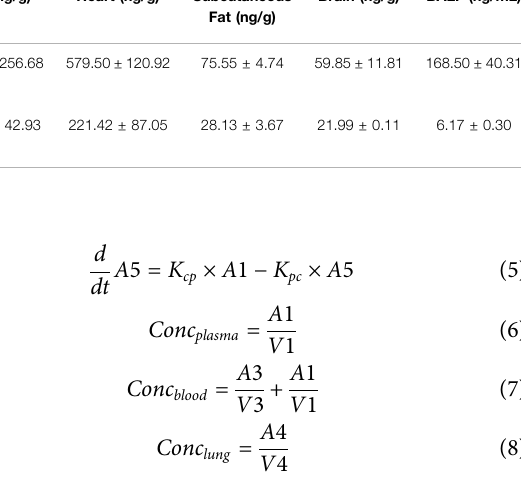
TABLE 3 | Tissues concentration (ng/g) and Kp_ tissue/plasma ratio of HCQ (mean ± SD). Liver (ng/g) Spleen (ng/g)